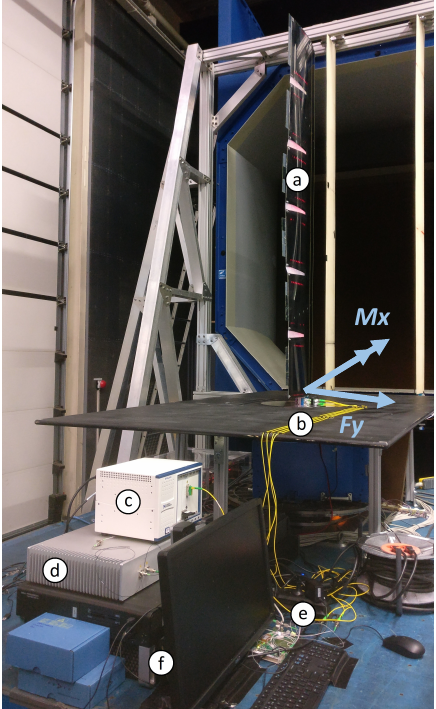
Figure 5. The experimental setup at the OJF (Open Jet Facility) low speed wind tunnel, showing the (a) wing, (b) optical fibers (yellow), (c) National Instruments interrogator, (d) Optics11 interrogator, (e) Thorlabs optical switch, and the (f) Data acquisition